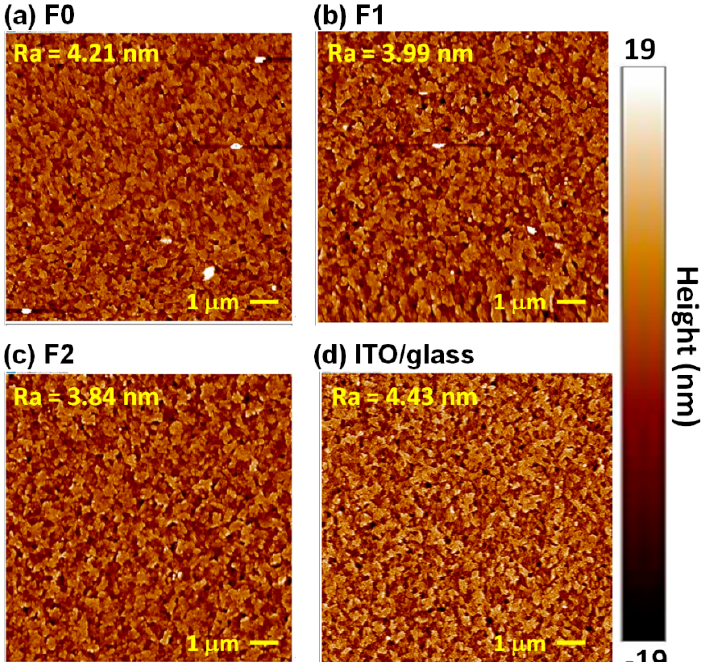
Figure 4. AFM images of P3CT-Na/ITO/glass substrates. ( a ) Without filter; ( b ) With single-filtering process; ( c ) With double-filtering process. ( d ) ITO/glass substrate.